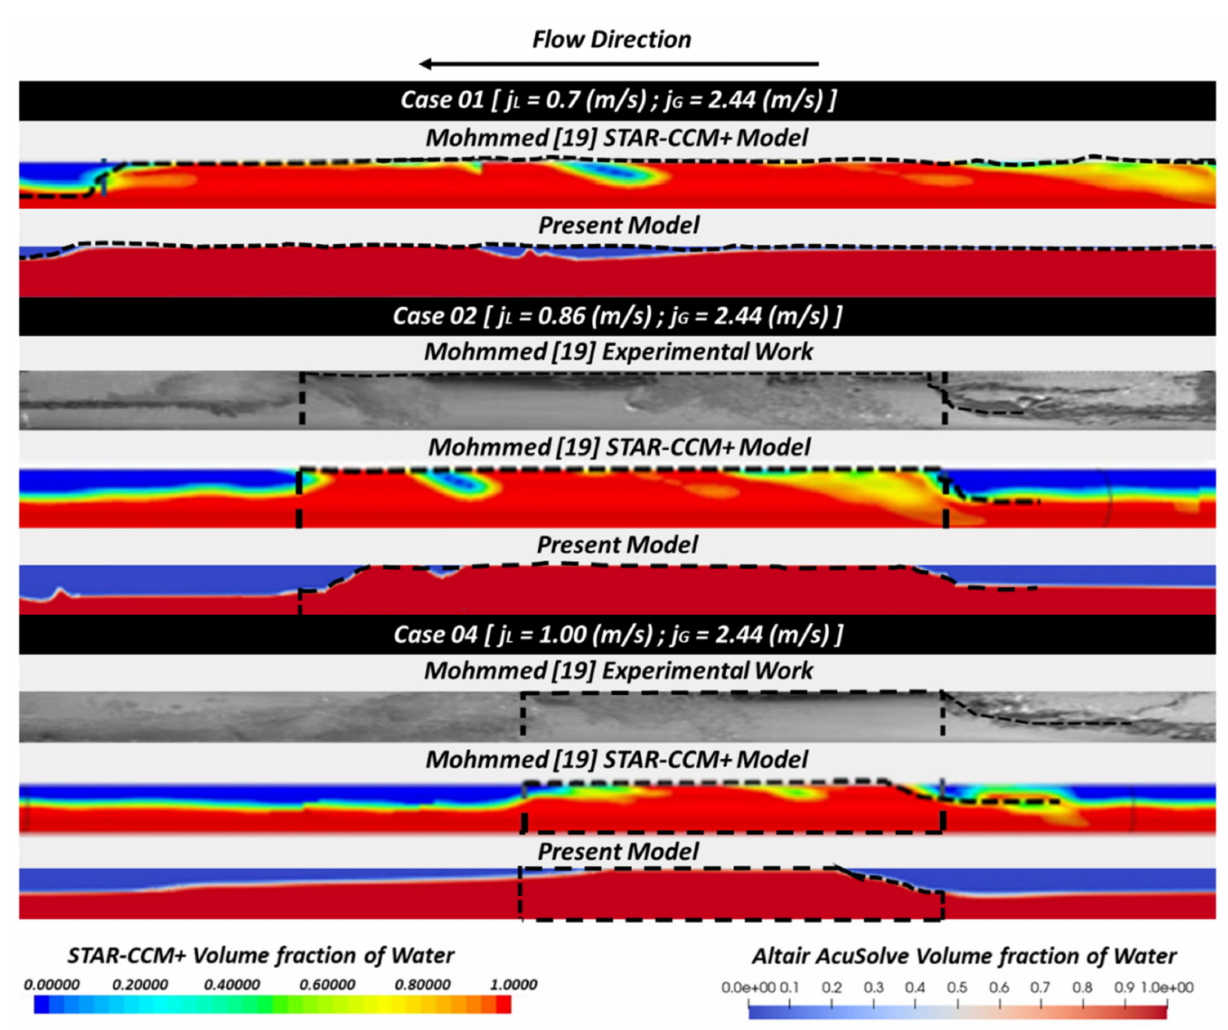
Figure 6. Qualitative validation of slug contours against the experimental work and numerical model of Mohmmed